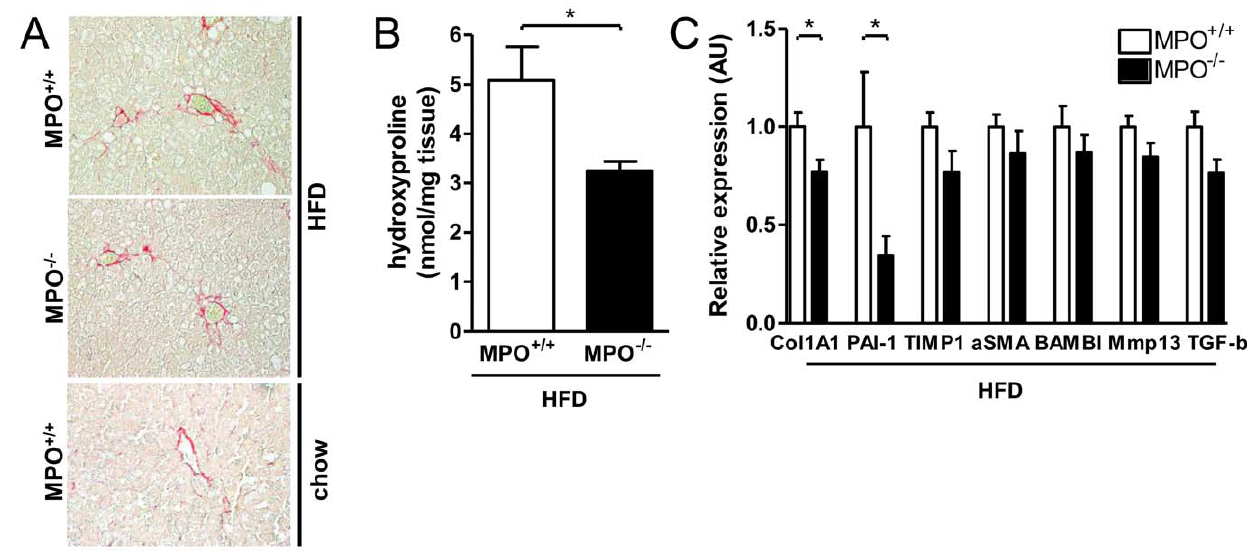
Figure 7. Attenuation of liver fibrosis in LDLR 2 / 2 / MPO 2 / 2 tp mice after 8 weeks high-fat diet. A) Sirius red staining of liver sections of LDLR 2 / 2 / MPO 2 / 2 tp , LDLR 2 / 2 / MPO + / + tp , and chow-fed LDLR 2 / 2 / MPO + / + mice (200 6 magnification). B) The amount of hydroxyproline, a protein modification specifically present in collagen and elastin, is significantly lower in the liver of LDLR 2 / 2 / MPO 2 / 2 tp mice in comparison with LDLR 2 / 2 / MPO + / + tp mice (3.3 6 0.2 vs. 4.6 6 0.7 nmol/mg tissue, p , 0.01). C) LDLR 2 / 2 / MPO 2 / 2 tp mice display reduced expression of collagen type I, PAI-1, TIMP1, a -SMA, MMP-13, TGF- b 1, and BAMBI, genes associated with hepatic fibrosis.